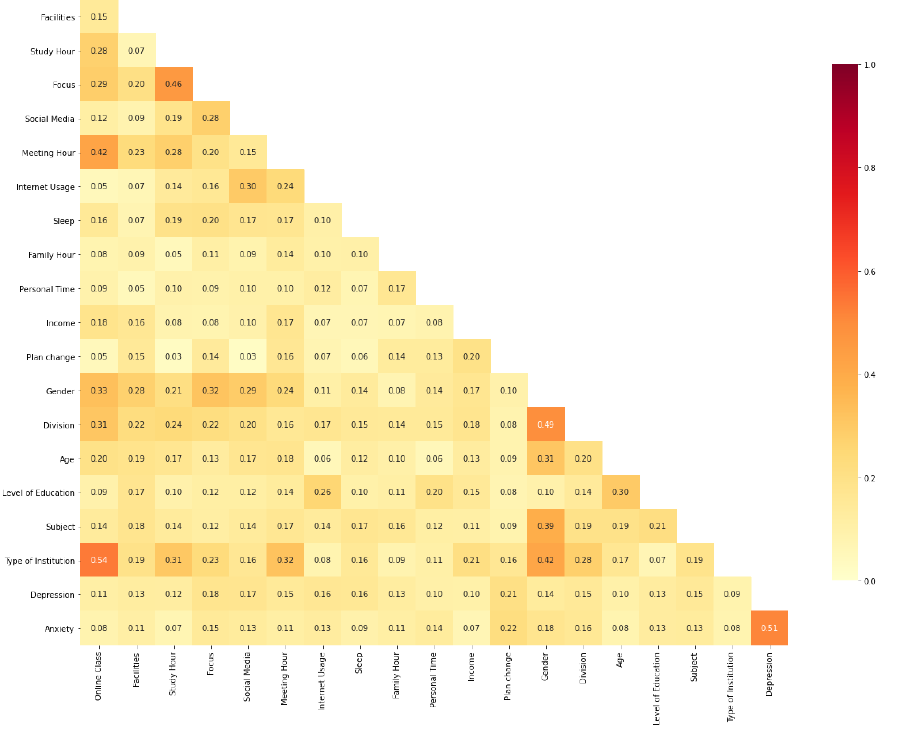
Figure 6. Correlation